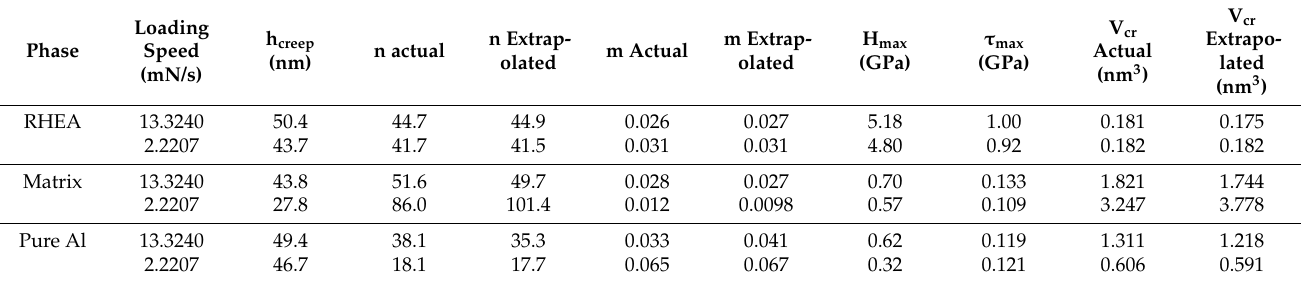
Table 3. Creep response assessment data.